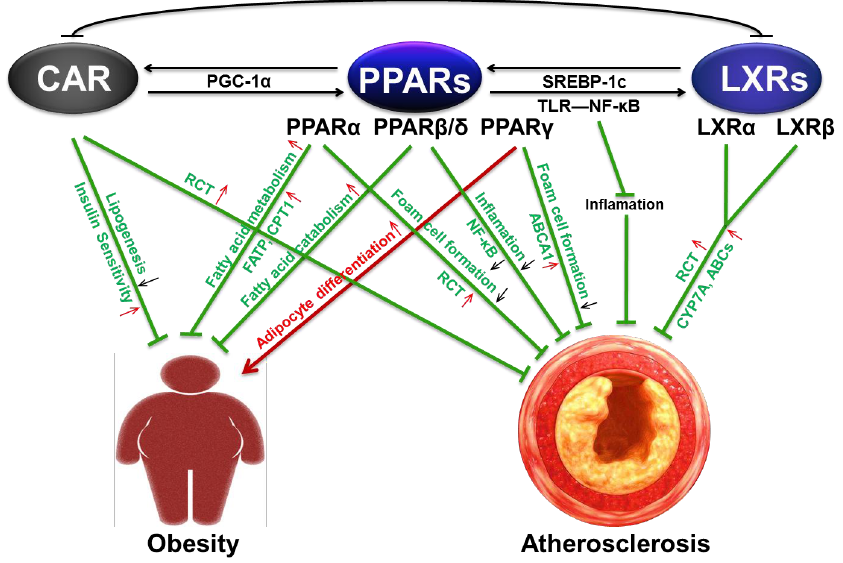
Figure 2. Proposed model of the cross-talks between PPARs and CAR in obesity and PPARs and LXRs in atherosclerosis. Red arrows: promotion; green T-bar: inhibition; red up-arrows: up-regulation; black down-arrows: down-regulation.